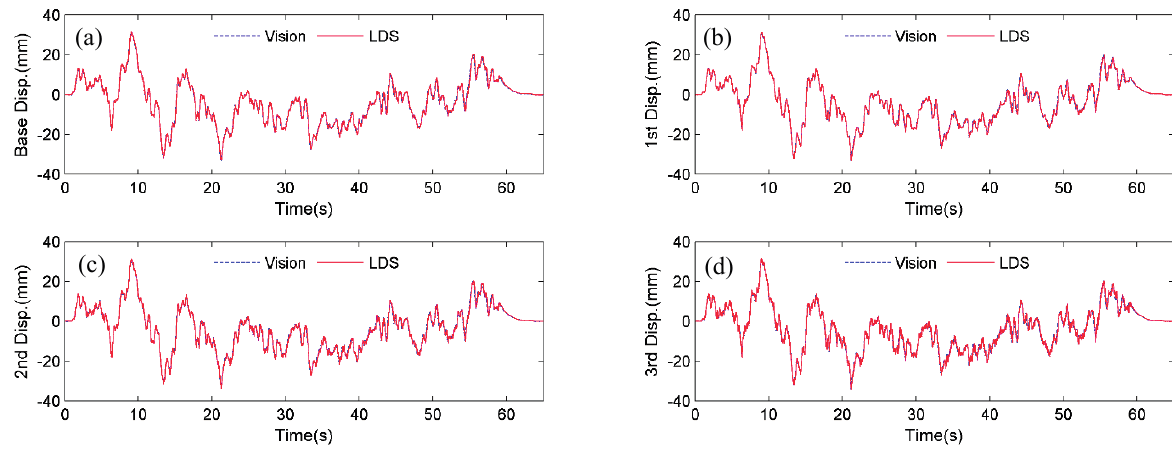
Figure 7. Displacement comparisons between Vision (artificial target) and LDS: ( a ) Base floor; ( b ) 1st floor; ( c ) 2nd floor; ( d ) 3rd